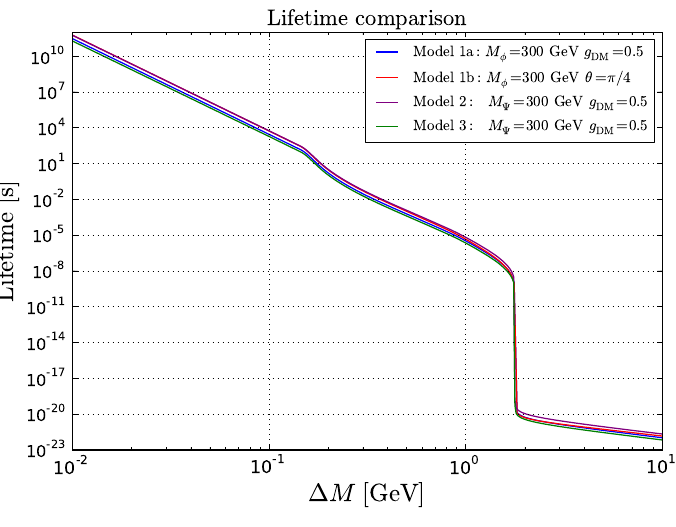
Figure 5 . The lifetime of the co-annihilation partner (cid:17) M (cid:17) m (cid:31) . Model 1a (blue): M (cid:30) = 300 GeV, g DM = 0 : 5, Model 1b (red): M (cid:30) = 300 GeV, (cid:18) = (cid:25)= 4, (cid:0) Model 2 (purple): M (cid:9) = 300 GeV, g DM = 0 : 5, Model 3 (green): M (cid:9) = 300 GeV, g DM = 0 :